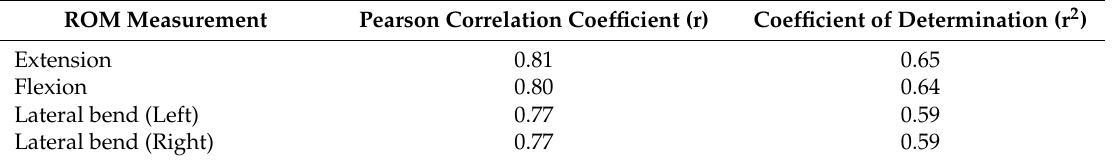
Table 3. Intra-rater reliability of the POF sensor and Biometrics goniometer.